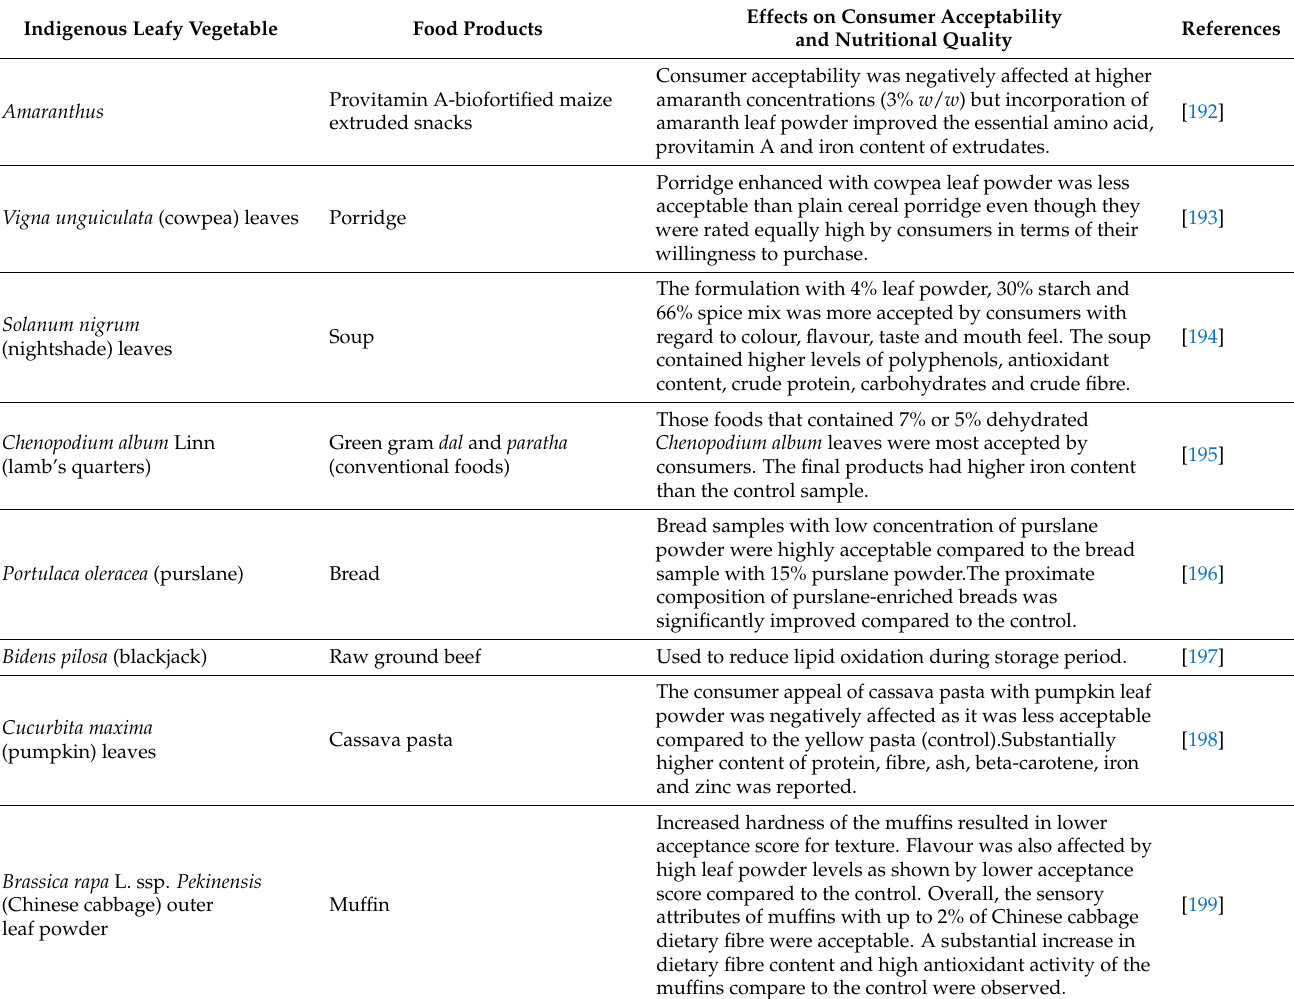
Table 5. Consumer acceptability and nutritional quality of food products enhanced with indigenous leafy